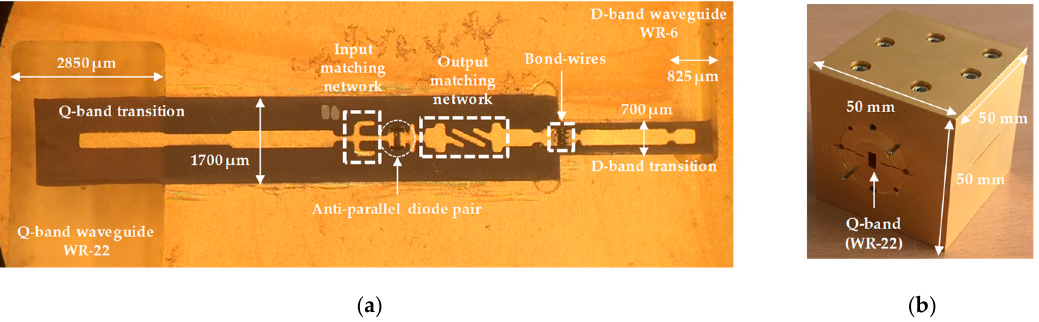
Figure 12. Fabricated D ‐ band frequency tripler module: ( a ) Internal view and ( b ) external view.